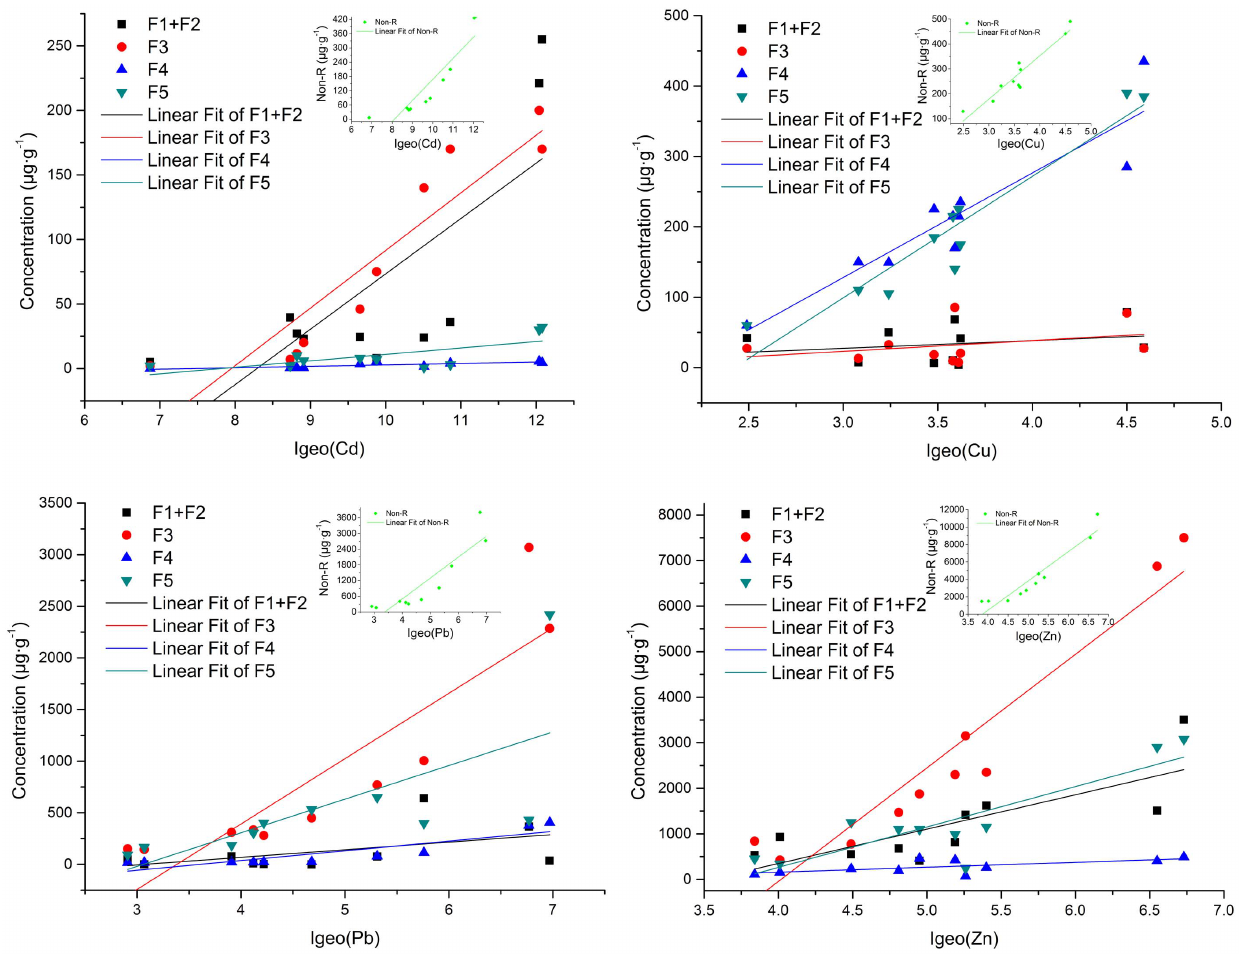
Figure 4. Relationships between the speciation concentrations and the corresponding I geo .